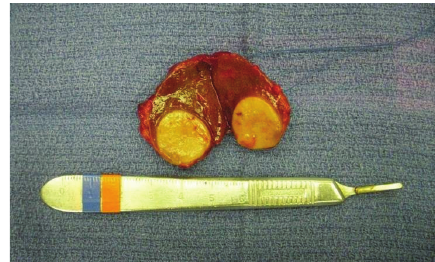
Figure 2: Right thyroid lobe excised from the horse. Note the circular parathyroid adenoma.